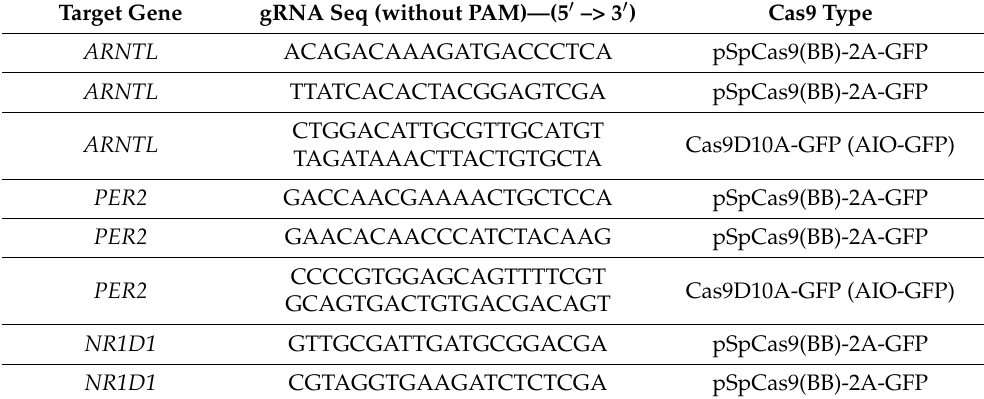
Table 1. List of gRNA sequences and Cas9 plasmids used for core-clock (CC) KO in HCT116 cells. For each target gene, multiple gRNAs binding different genomic regions were used to increase KO efficiency. Target